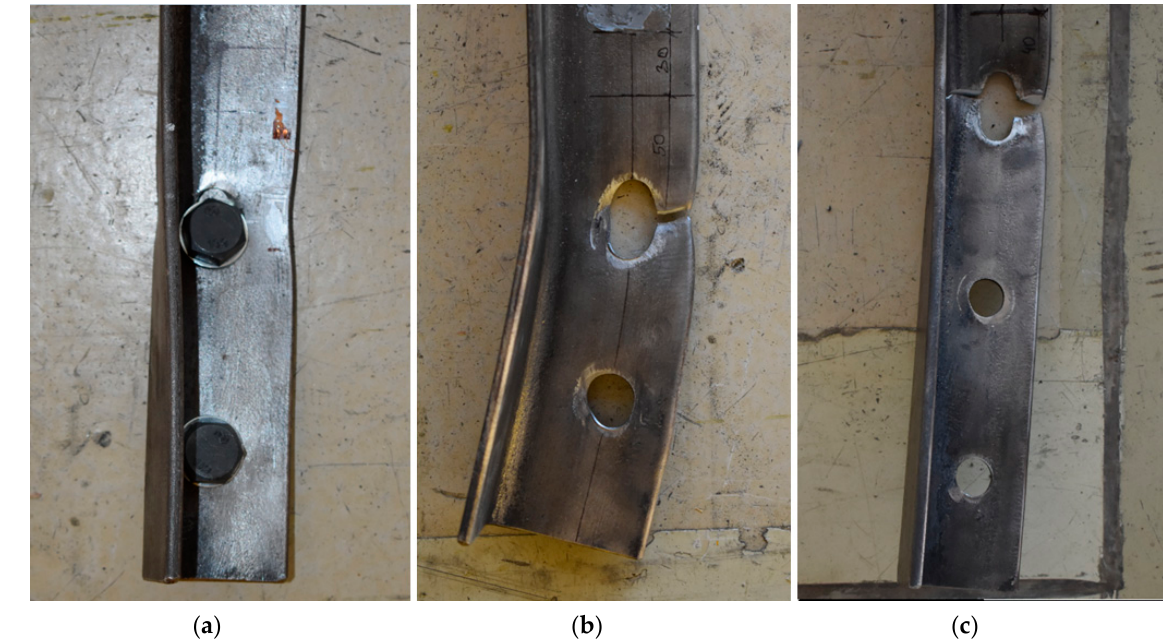
Figure 3. Failure modes of specimens: ( a ) shear of bolts “BF”, specimen J6/2/90/34; ( b ) tearing across the width of connected leg “FI”, specimen J8/2/80/30; ( c ) tearing developed towards outstanding leg “FP”, specimen J6/3/90/25.